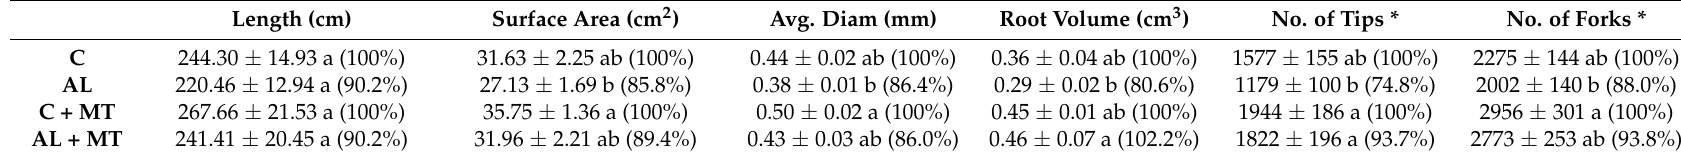
Table 4. Effects of 5 µ M melatonin treatment on root growth from Malus hupehensis Rehd. seedlings under alkaline